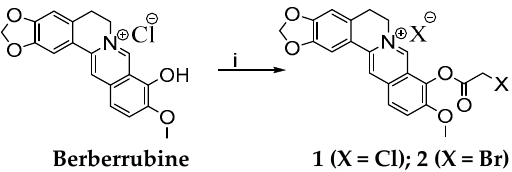
1 H NMR: (CD 3 OD) δ 9.28 (s, 1H, H-8), 8.70 (s, 1H, H-13), 7.54 (t, 1H, 3 J HH =8.04 Hz, H-12), 7.49 (s,